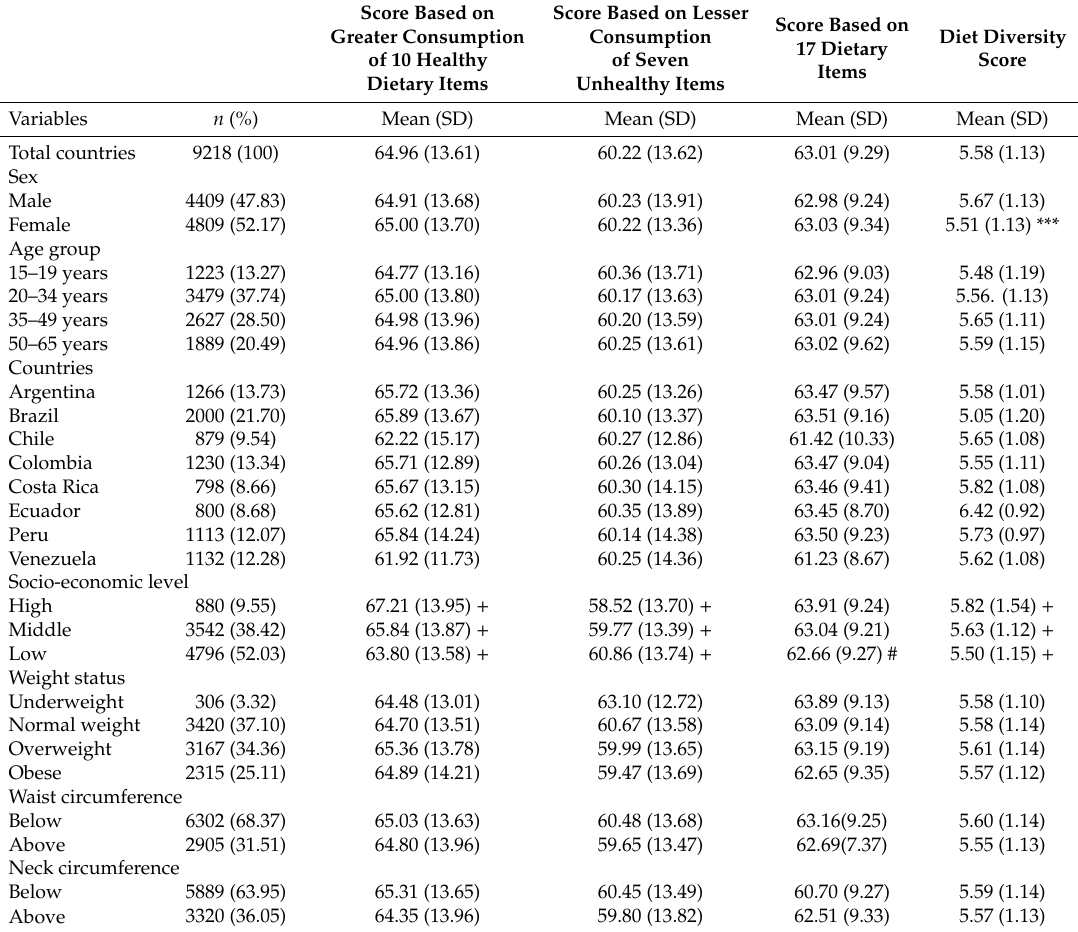
Table 3. Global dietary patterns in individuals residing in urban areas of Latin American countries, according to country, sex, age groups, socioeconomic level, and weight status. Score Based on Greater